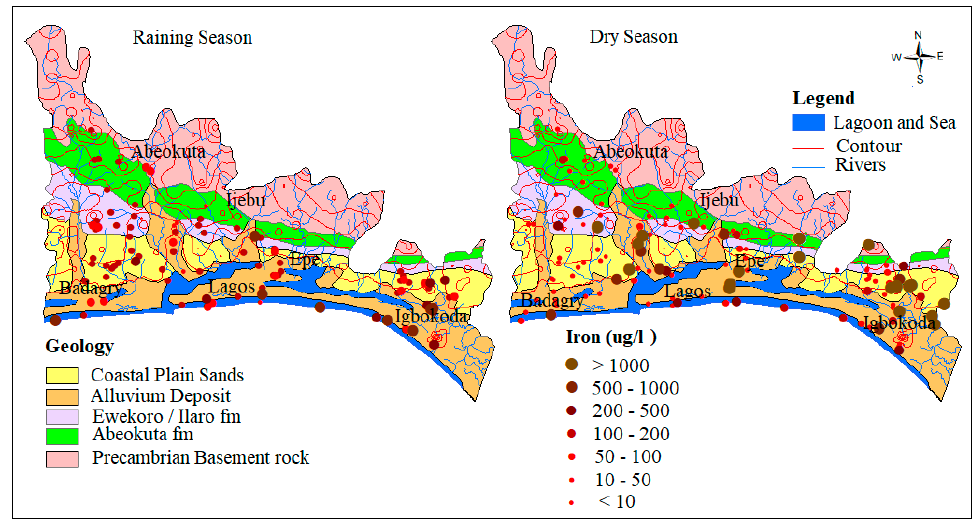
Figure 7. Spatial distribution of Fe 3+ in µg/L.